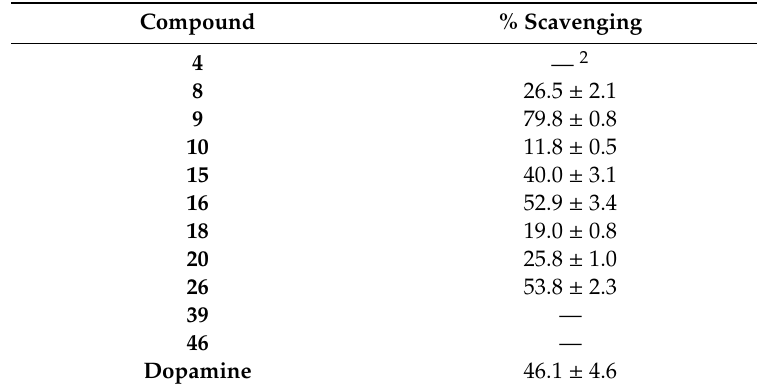
Table 2. H 2 O 2 scavenging properties 1 .